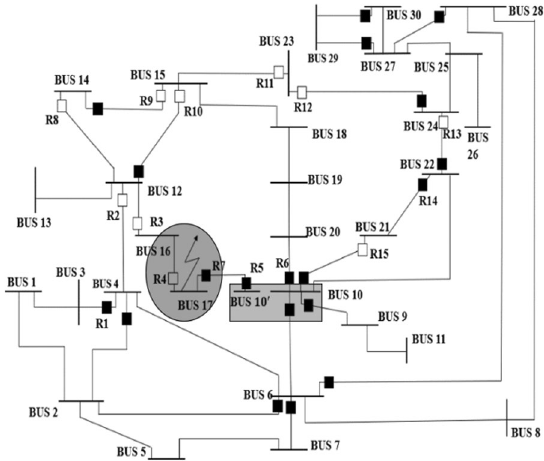
Fig. 9 IEEE 30-bus system with single fault and busbar splitting scheme incorporated